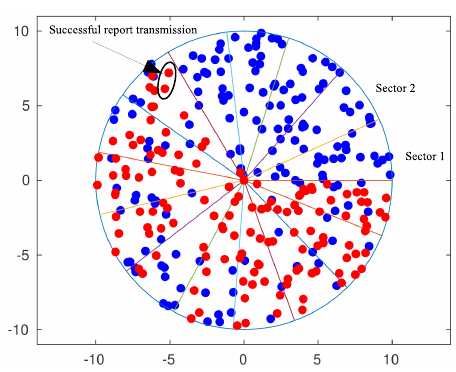
Figure 12. Sensors deployment (red denotes sensors with successful report